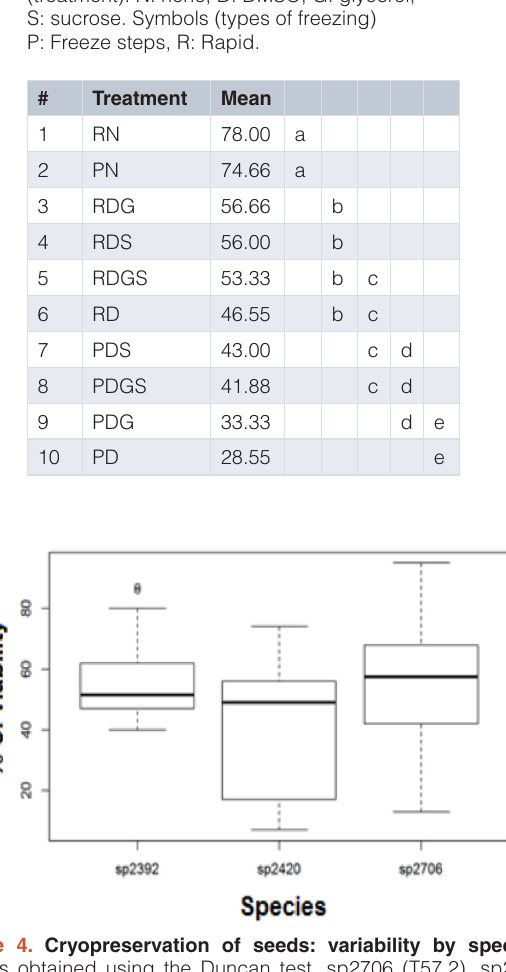
Table 4. Duncan test groups obtained after cryopreservation test. Results are given as orchid seed viability percentage; a, b, c and d, indicate groups with statistical significance. Classification was made under an alpha of 0.01, and 78 degrees of freedom for error. Symbols